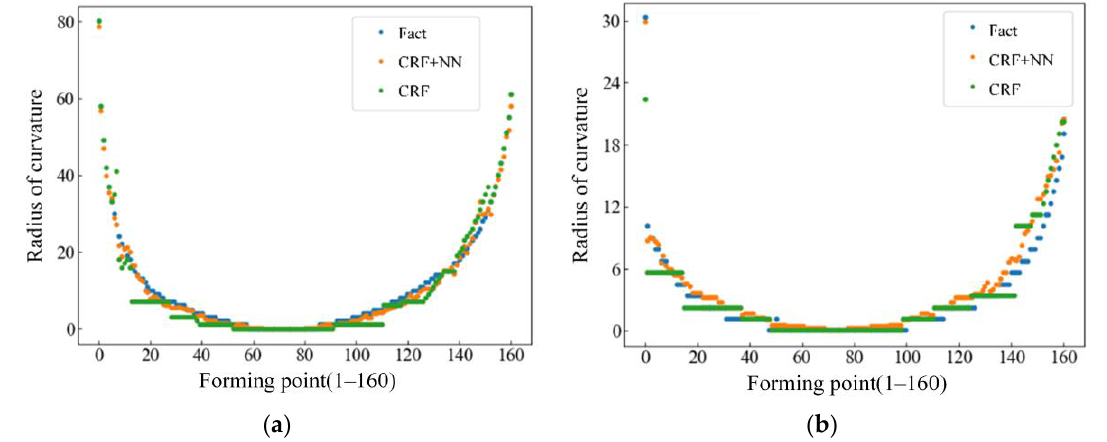
Figure 14. Experimental comparison with error compensation network. ( a ) Experiment No.1; ( b ) Experiment No.2. Table 8. Prediction and evaluation results of curvature radius after springback in variable-curvature roll bending based on conditional random